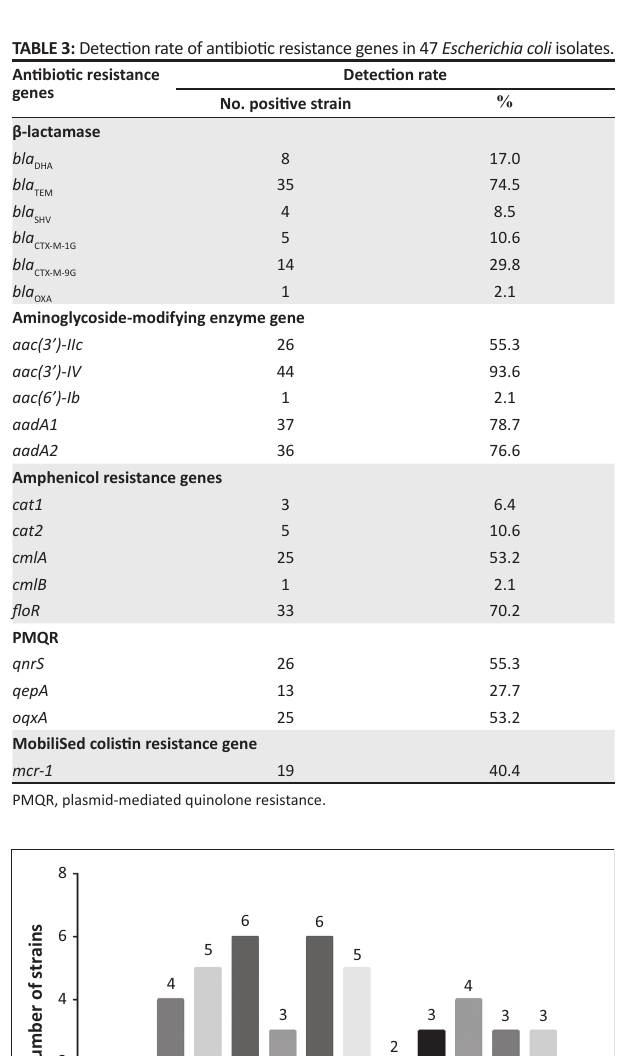
22 3 Multiple gene strain The type of gene carried by the strain FIGURE 3: Genetic compositions of CTX-M positive strains. Left column: multiple gene strains, Right column: single gene strains.